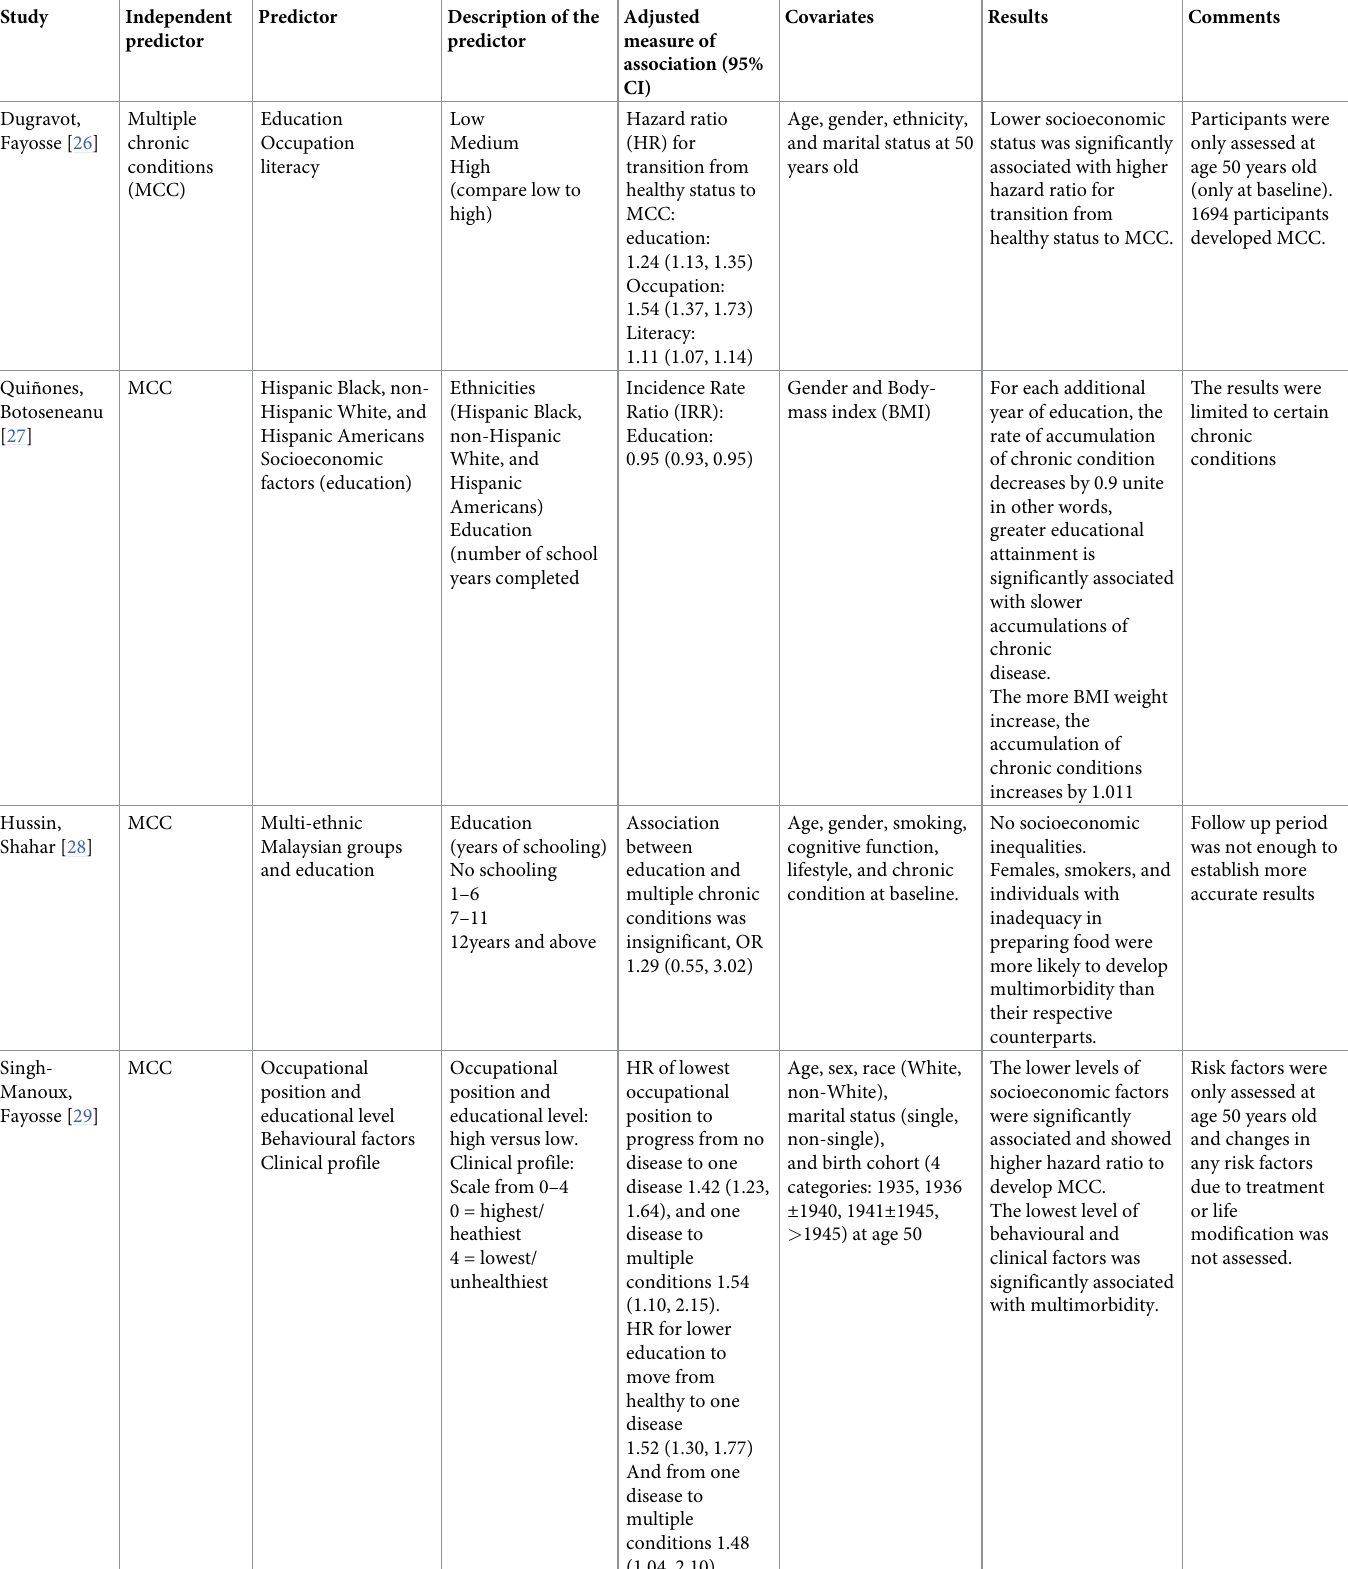
Table 3. Association between socioeconomic factors and progress of multiple chronic